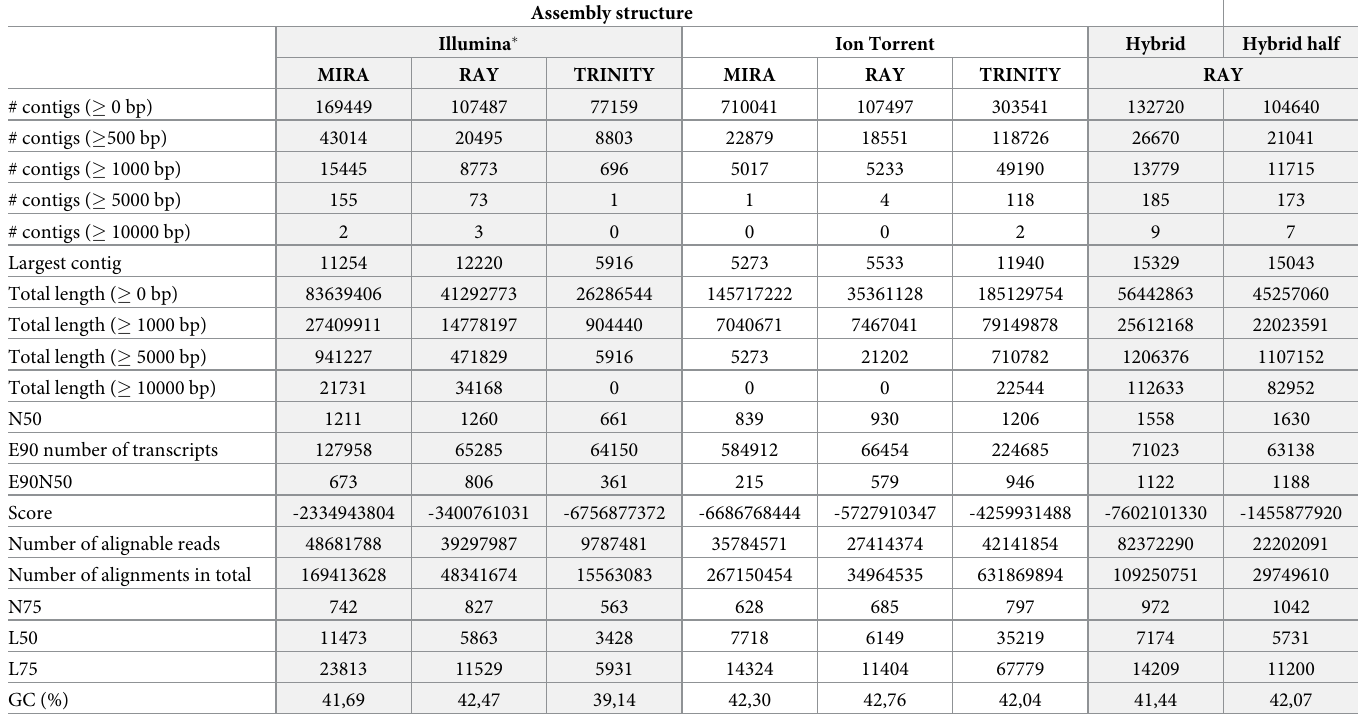
Table 1. Summary of the structure of the holm oak